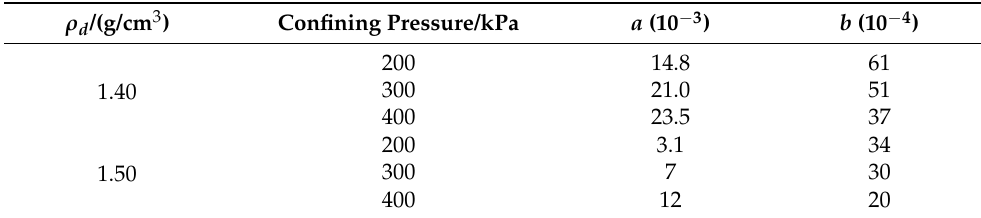
Table 3. Fitting line